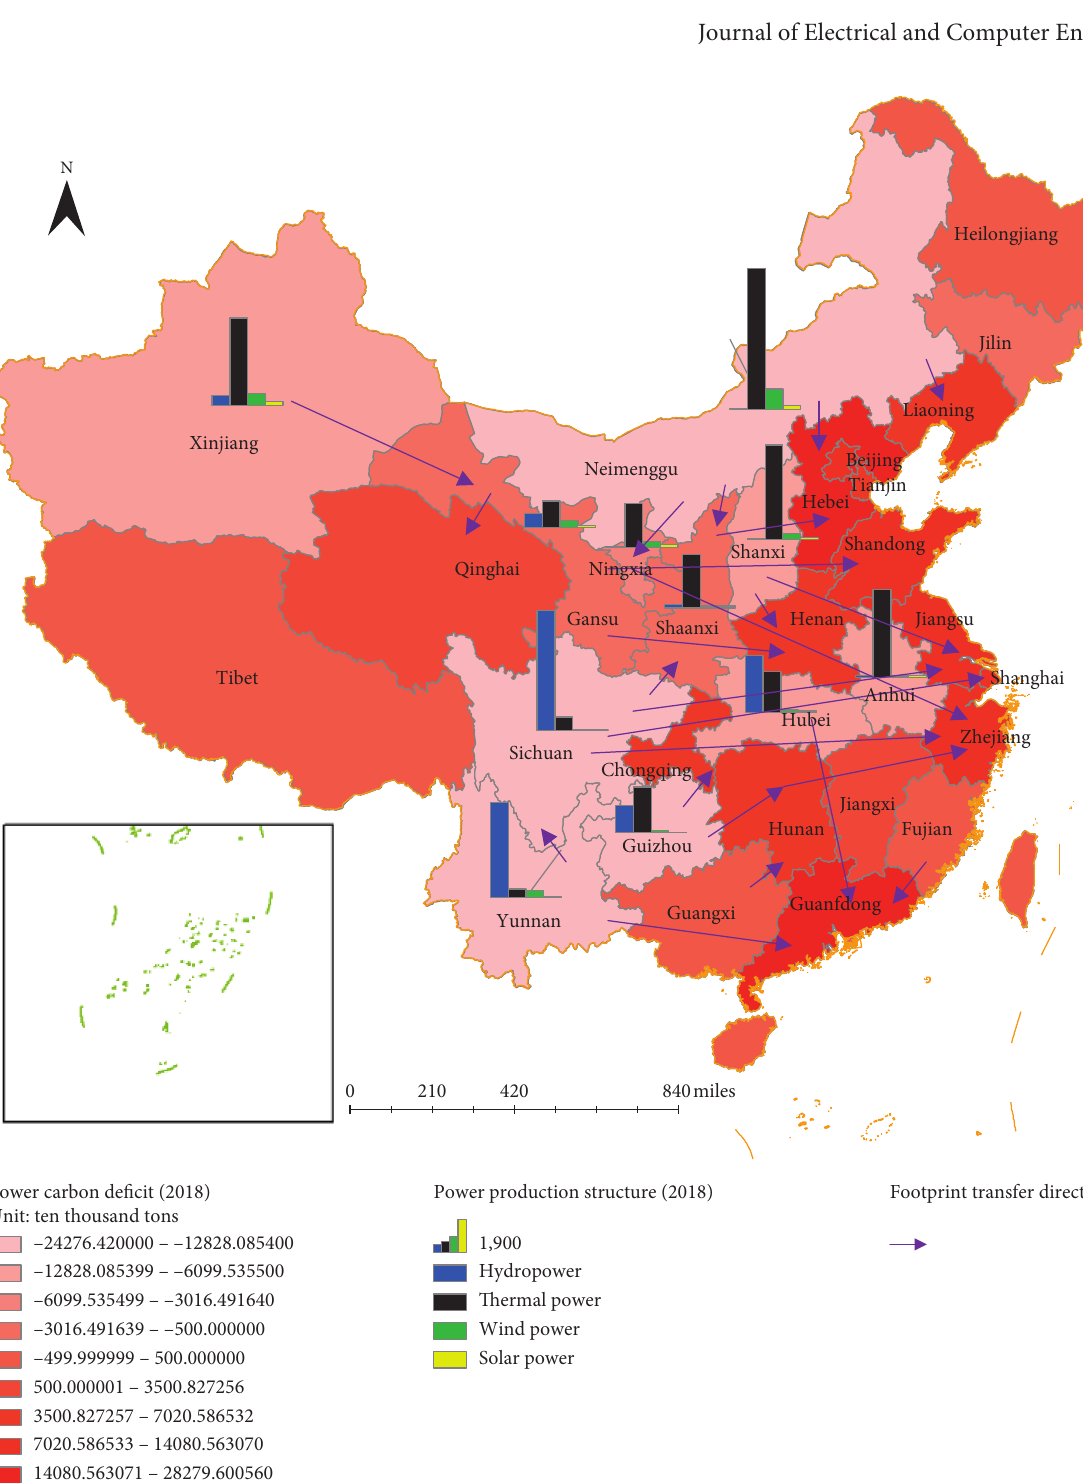
Figure 9: Distribution map of China’s power carbon footprint deficit in